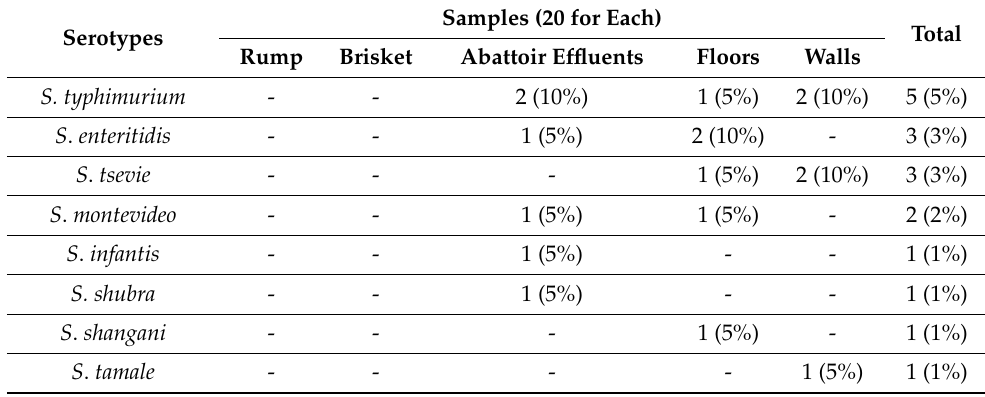
Table 1. Prevalence of Salmonella species in the examined abattoir samples. Serotypes